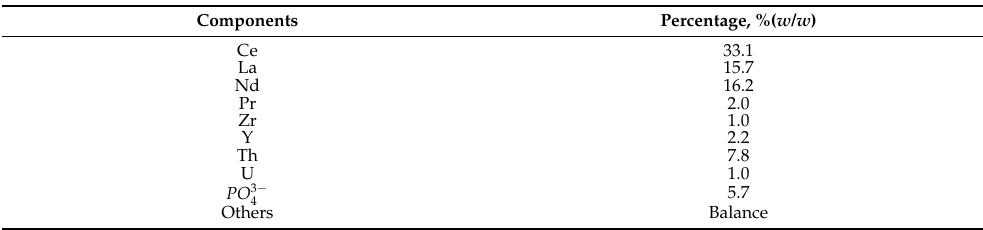
Figure 12. X-ray diffraction patterns of the monazite concentrate after the roasting process at 500 ◦ C at times of (a) 60 min; (b) 90 min; (c) 120 min. Table 3. Chemical composition by ICP-OES of the monazite concentrate after the roasting process at 500 ◦ C, at time of 120